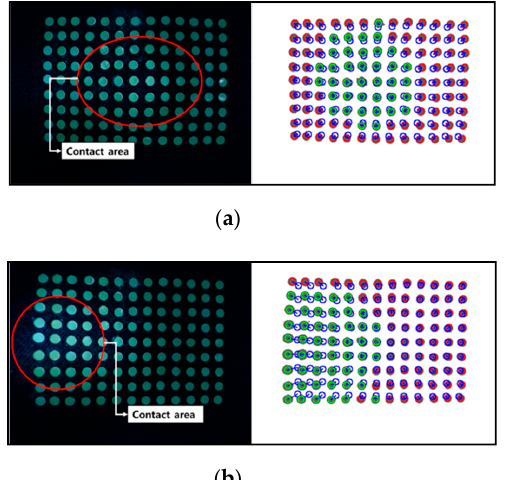
Figure 7. Identifies the tendency to change the features of the marker according to the contact location ( a ) the camera view when pressing the center of the contact surface ( b ) the camera view when pressing the outer of the contact